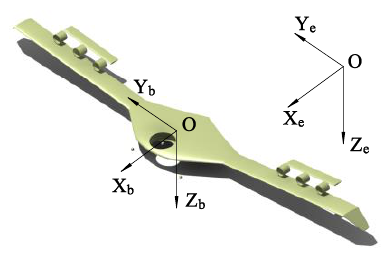
Figure 1. Body coordinate system.